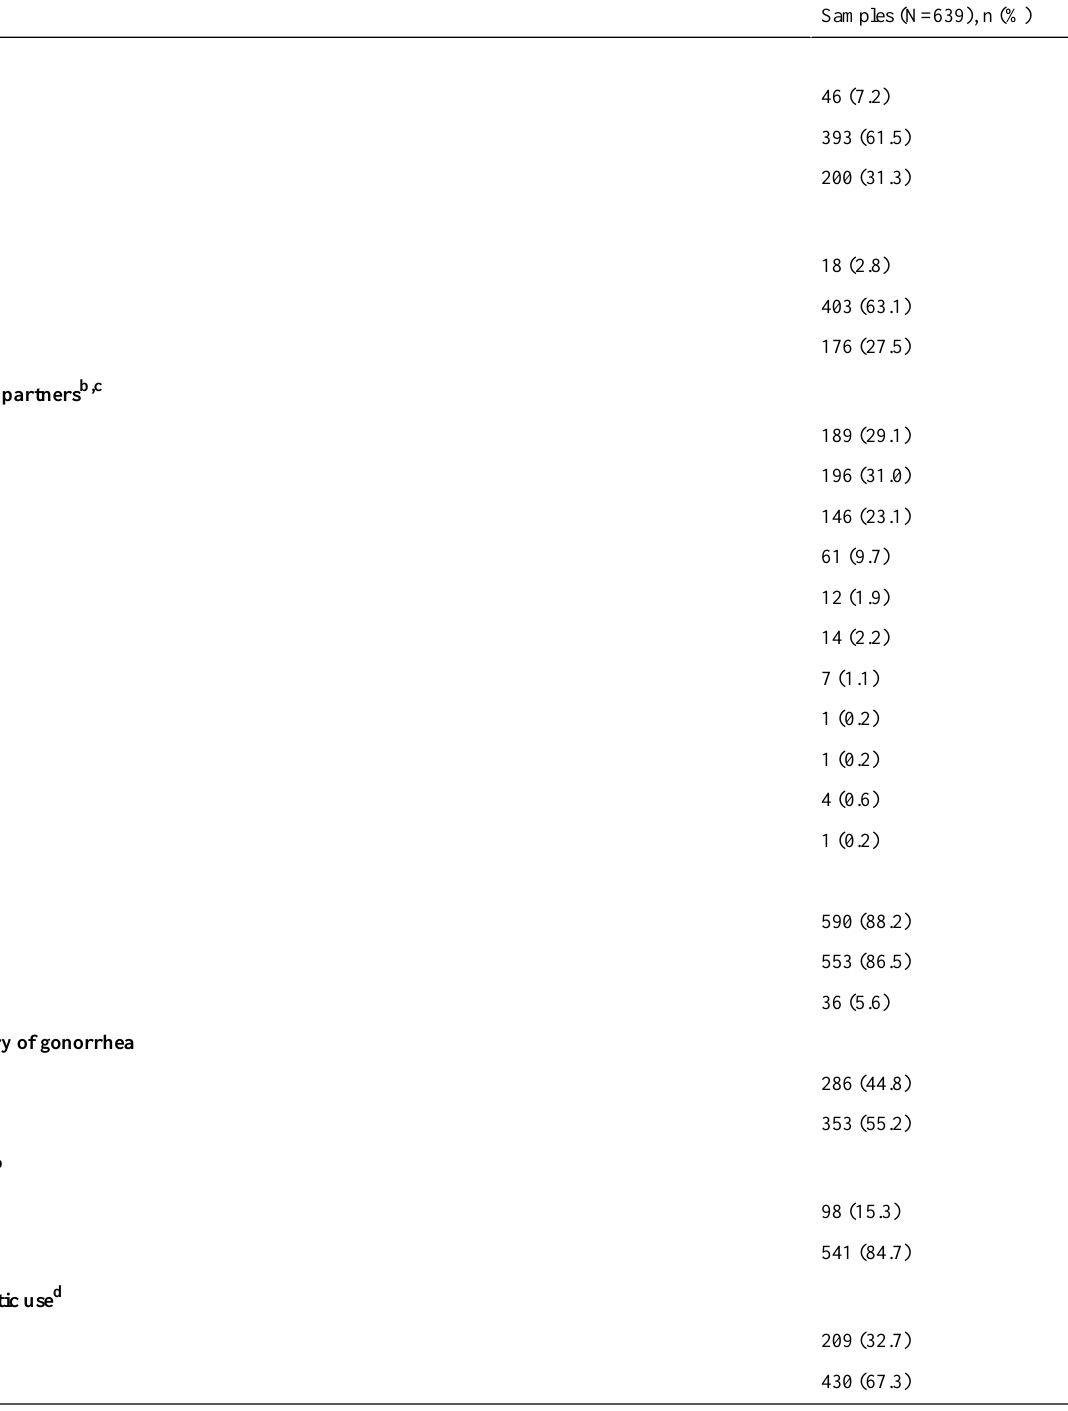
Table 1. Demographic, health-related, and behavior